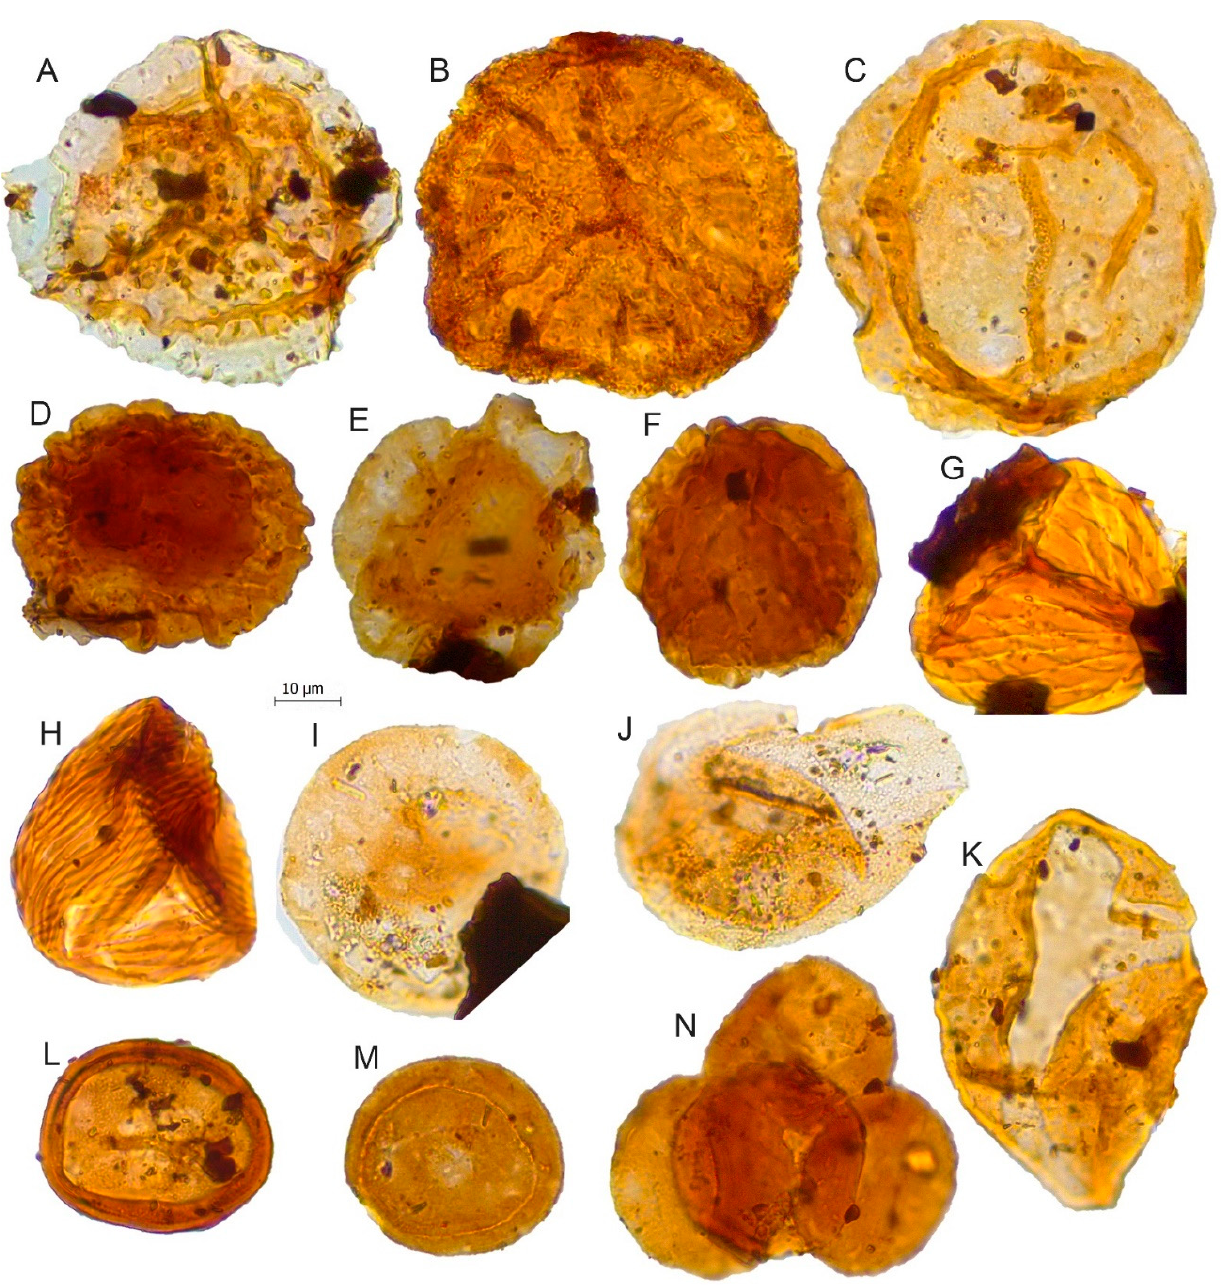
Figure 8. Scale bar: 10 µm. ( A ) Aequitriradites spinulosus , JVLP-A-M260; ( B ) Densoisporites velatus , JVLP-A-EX-G271; ( C ) Araucariacites australis , JVLP-1-2-J494; ( D ) Callialasporites segmentatus , JCLP-E-1-U120; ( E ) Callialasporites trilobatus , JVLP-3-1-V240; ( F ) Callialasporites microvelatus , JVLP-3-1-K494; ( G ) Ruffordiaspora sp.1, JVLP-A-EX-Q121; ( H ) Ruffordiaspora australiensis , JCLP-C-1-D280; ( I ) Exesipollenites tumulus , JVLP-3-1-G391; ( J ) Perinopollenites elatoides , JVLP-3-1-G490; ( K ) Cycadopites follicularis, JVLP-2-4-K310; ( L ) Classopollis classoides , JCLP-E-2-N254; ( M ) Classopollis simplex , JVLP-3-2-D421; ( N ) Tetrad of Classopollis sp., JVLP-2-4-E210.